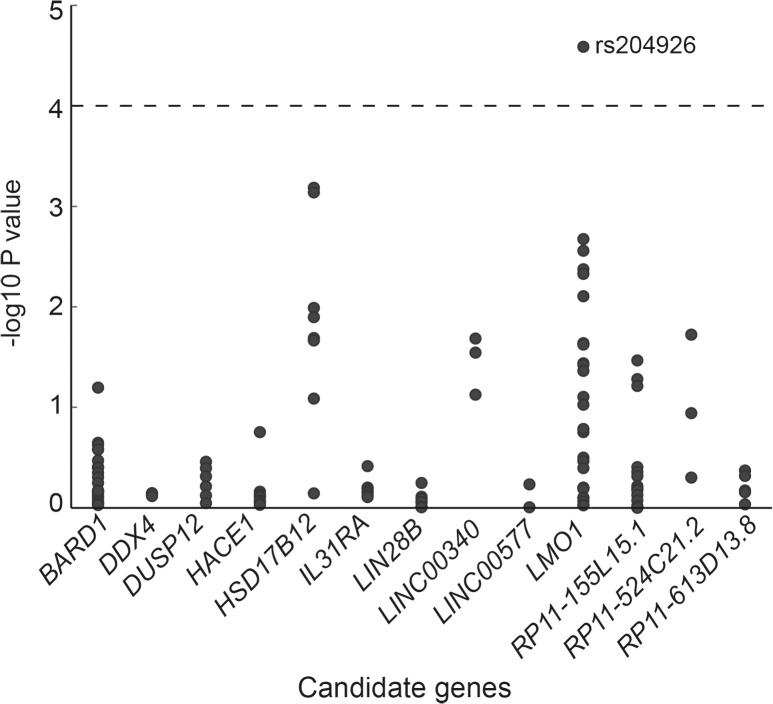
Association results from 127 SNPs using the additive model.For each SNP in the genes shown on the x-axis, the-log10 P (unadjusted P value) from the logistic regression analysis is indicated on the y-axis. The dashed horizontal line represents the significance threshold (P < 0.0001).